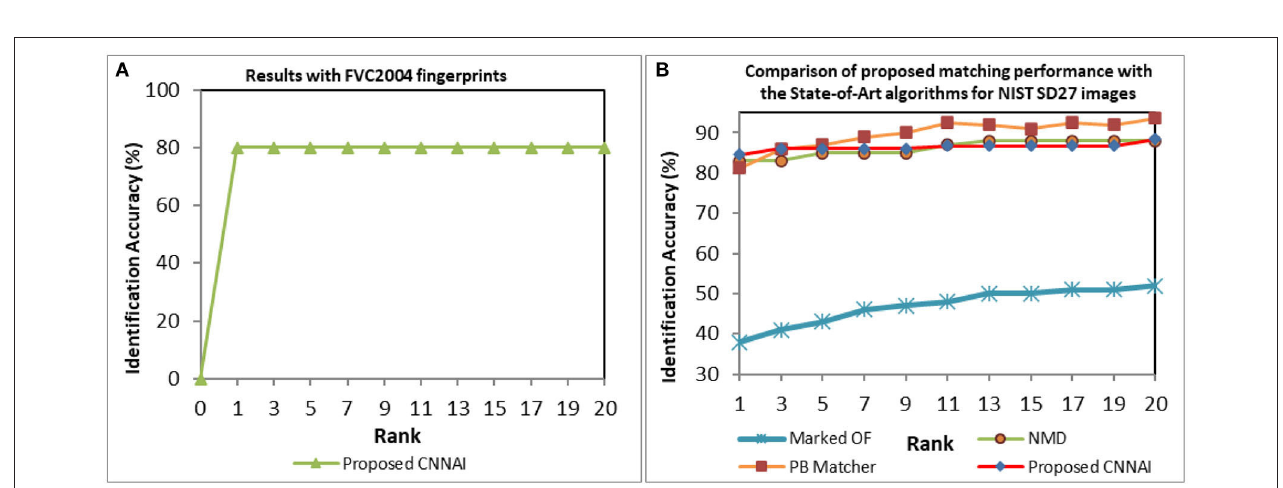
FIGURE 9 | CMC curves indicating fingerprint matching results (A) FVC2004 database. (B) NIST SD27